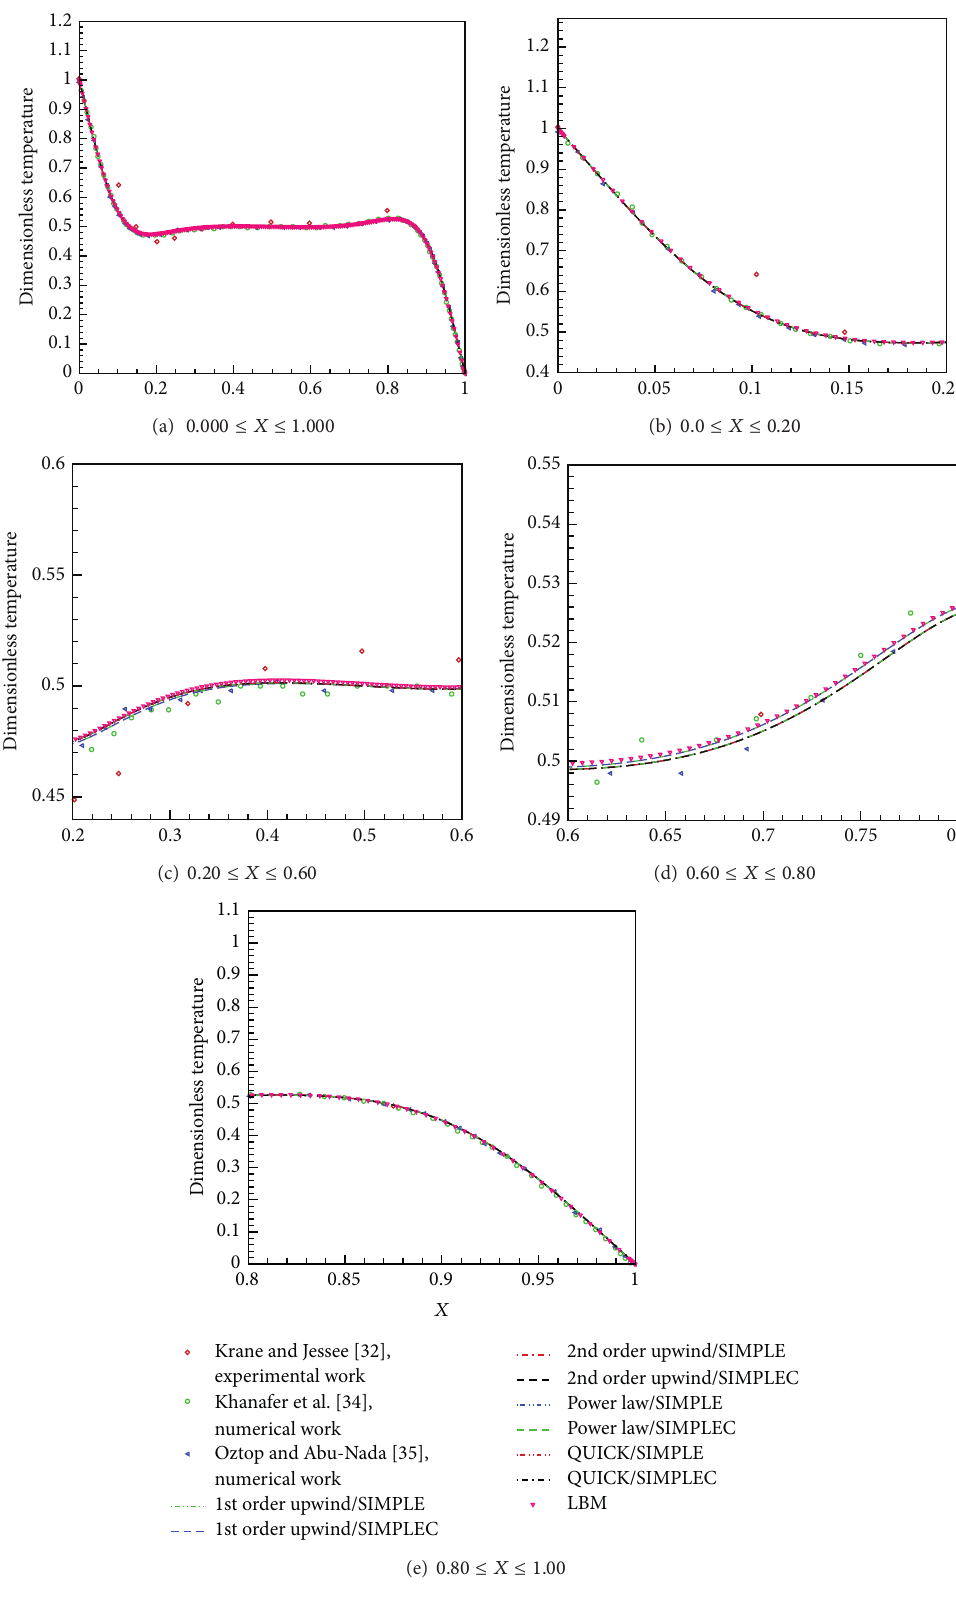
Figure 2: Dimensionless temperature representation at